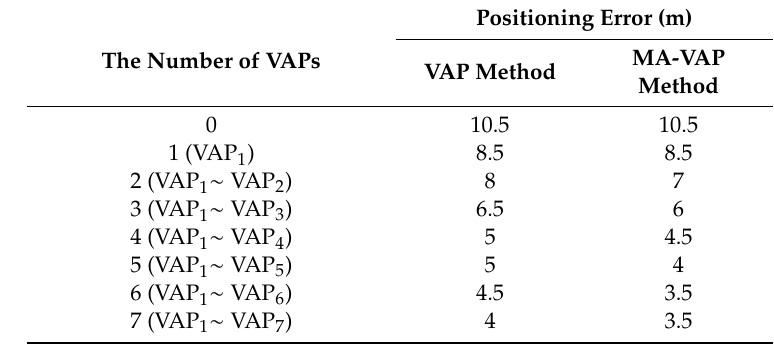
Table 1. Positioning errors of the VAP method and the MA-VAP method at the 90% CDF for eight